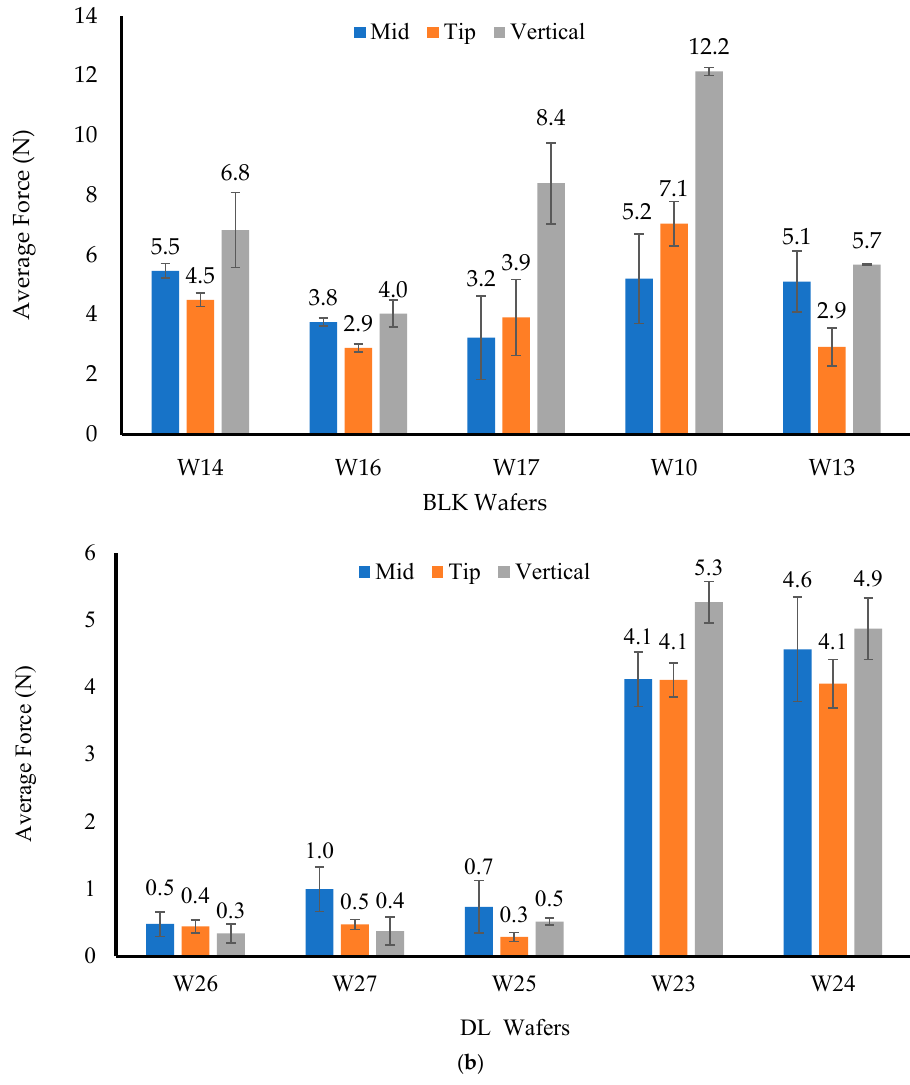
Figure 1. Mechanical properties of BLK ( a ) and DL ( b ) wafers.